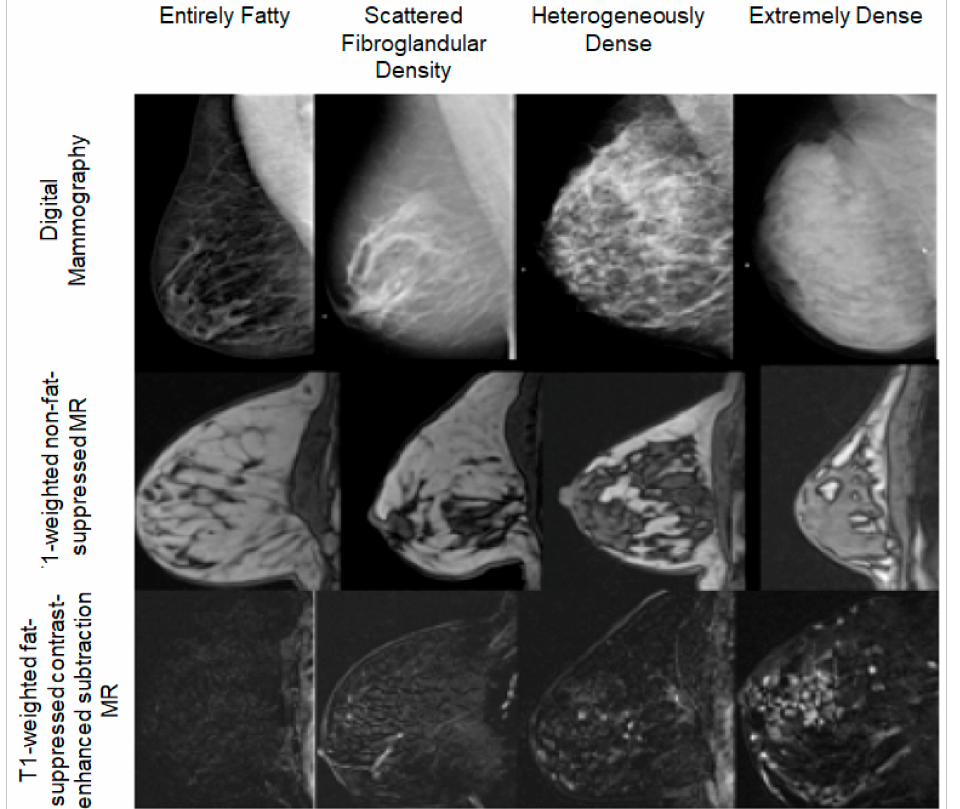
Figure 1. Imaging appearance of different breasts of increasing density using three types of imaging modalities. Digital mammography depicts how breasts appear more opaque as breast density increases. T1-weighted non-fat-suppressed MR images show increasing amount of fibroglandular tissue (FGT). T1-weighted fat-suppressed contrast-enhanced subtraction MR images show increasing amounts of background parenchymal enhancement (BPE), which reflects the vascularity of the fibroglandular tissue. (Adapted from